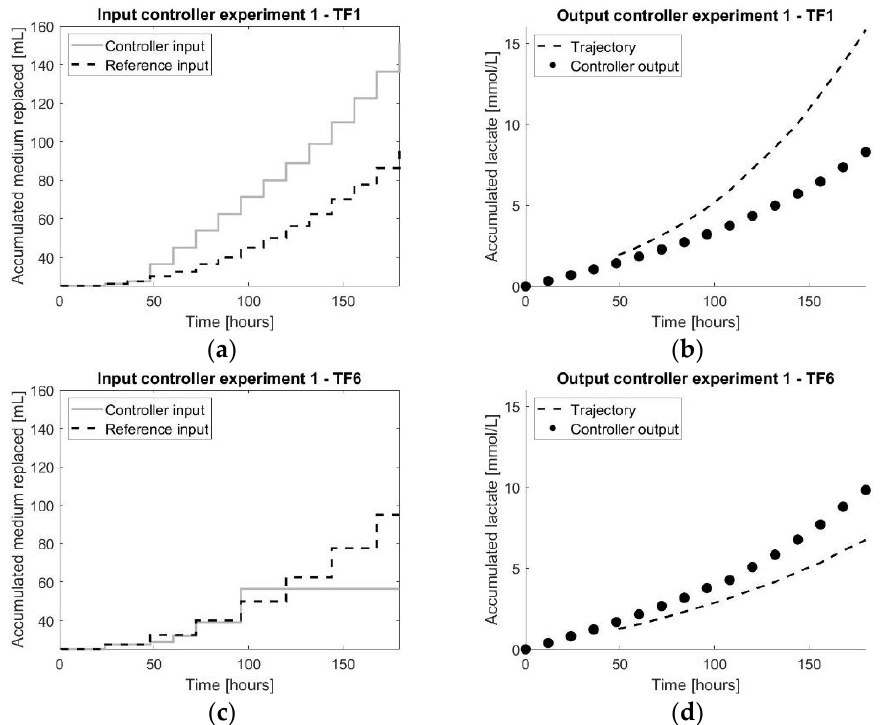
Figure 6. The results of the first controller experiment: ( a , c ) representing both the input values of the controller experiment as well as the reference experiment for TF1 and TF6, respectively; ( b , d ) representing both the output measurements of the controller experiment as well as the reference experiment for TF1 and TF6, respectively.